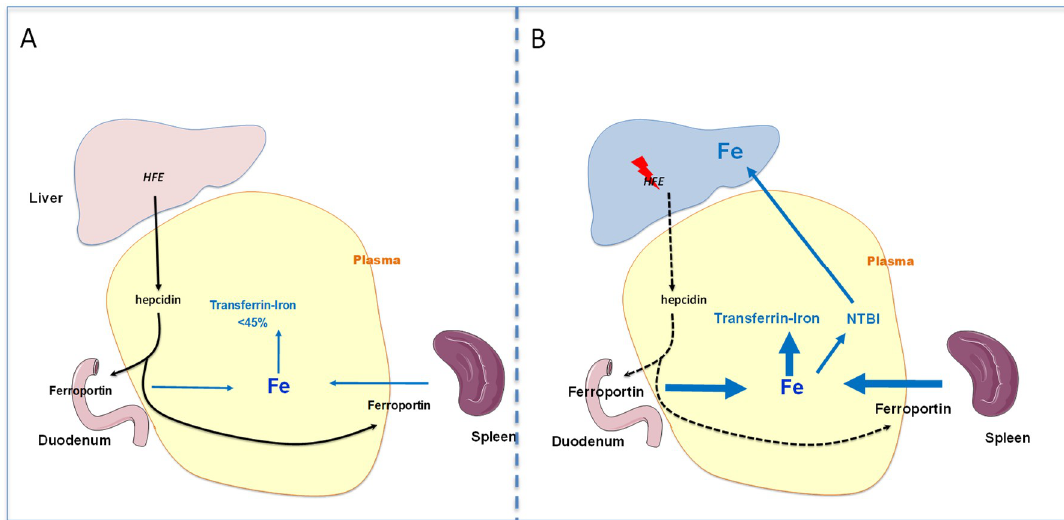
Figure 1. Schematic representation of the pathophysiological mechanisms leading to the development of iron overload during HFE -related hemochromatosis. ( A ): Normal situation with adequate HFE signaling allowing control of transferrin saturation level (<45%). ( B ): Genetic hemochromatosis with low activity of HFE -related signaling that limits hepcidin expression and in turn favors iron release in plasma, despite the presence of a sufficient amount of iron. Thus, the transferrin saturation increases and non-transferrin bound iron appears and targets organs such as liver, leading to abnormal iron accumulation.